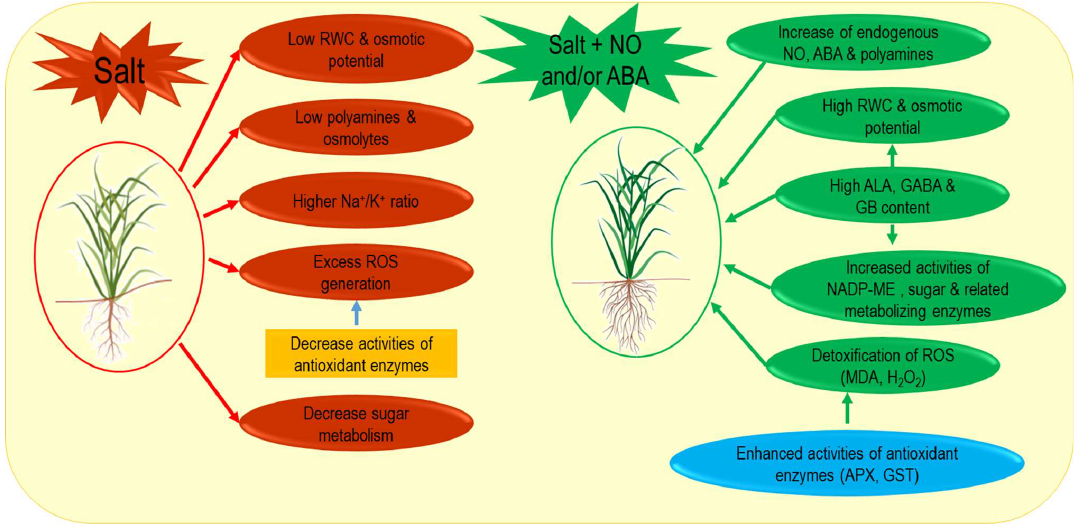
Figure 13. Summary of the protective role of NO and ABA in conferring salt tolerance in rice based on the present experimental results. Swarna was much more affected by salt compared to Swarna Sub1, while the protective effects of NO and/or ABA were more prominent in the cultivar Swarna Sub1. Supplementary Materials: The following are available online at www.mdpi.com/xxx/s1, Figure S1: Growth of seedling in two rice genotypes Rice (cv Swarna and cv. Swarna Sub1) under salinity stress.